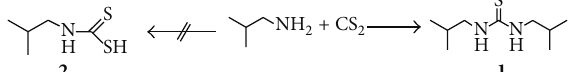
Table 1: Crystal data and structure refinement.